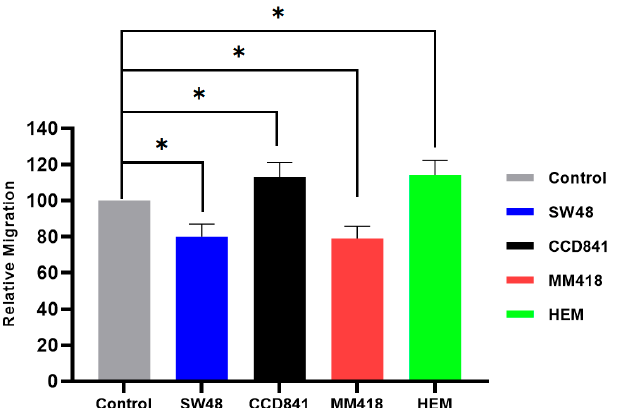
Figure 4. Effect of AuNPs + IR on the viability of human colon adenocarcinoma (SW48) and melanoma (MM418-C1) cell lines compared to their non-cancerous counterparts (CCD841 and HEM cells). The cells were treated with 1 mM AuNPs for 24 h prior to being exposed to 0–6 Gy of 6 MV X-rays. Cell viability (% viability) was measured 48 h post-irradiation using the MTS assay. Results are expressed as the mean ± SEM of 3 replicates. Significance of different treatments com- pared to control is represented by black lines shown as * p < 0.05 05 and ** p < 0.01. .